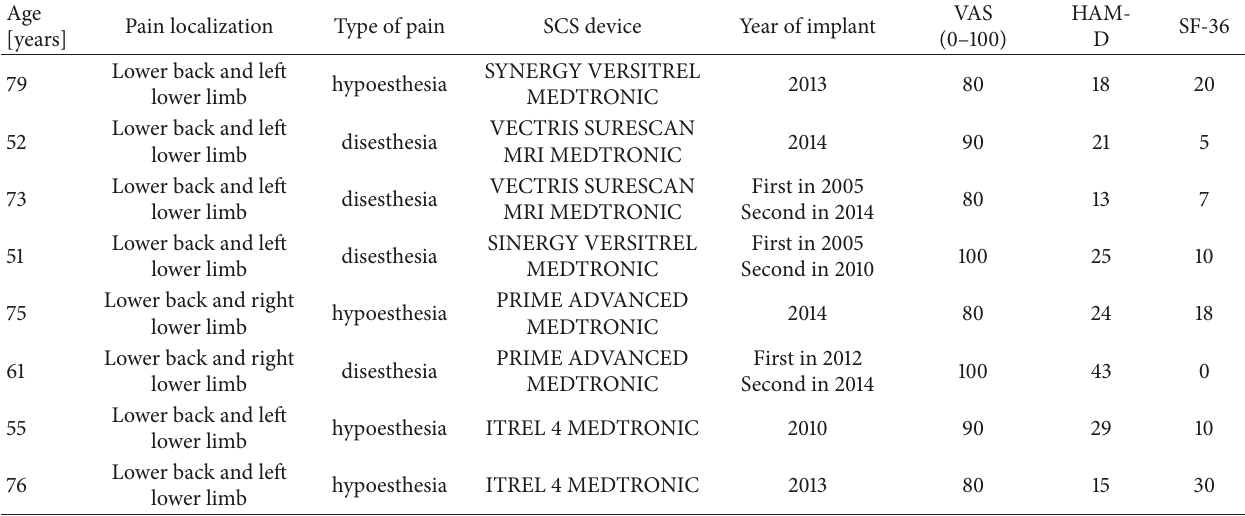
Table 1: The general picture at T0: patients’ clinical features, model of SCS device, year of implant of the device, clinical scales (Visual Analogue Scales (VAS), Hamilton Depression Rating Scale (HAM-D), and Short Form Health Survey-36 (SF-36)), and functional scores (Medical Research Council, Timed Up and Go). HAM-D scores of 0–7 are considered to be normal; scores of 8–17 indicate a mild depression, scores of 18–24 a moderate depression, and scores > 25 a severe